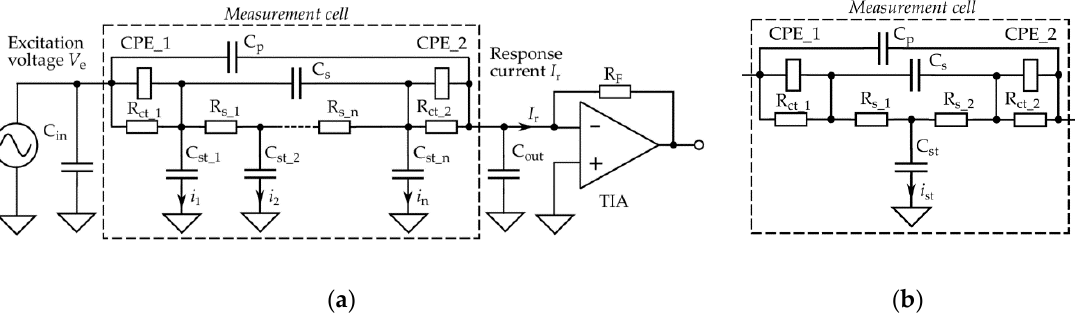
Figure 21. Measurement circuitry with more detailed electrical model of the measurement cell ( a ) and its simplified variant ( b ).